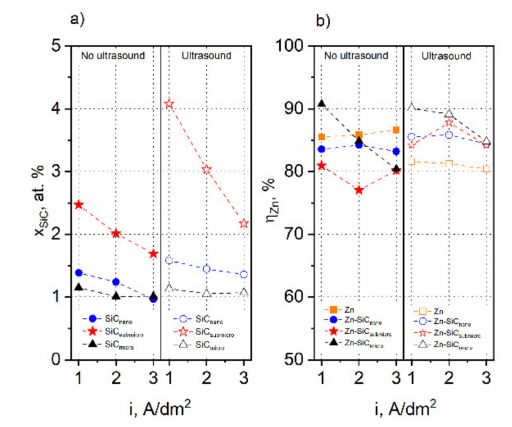
Figure 1. Parameters of coatings deposited at different current densities from an SiC free electrolyte and an electrolyte containing 5 g/L of SiC particles of different sizes. Coatings were deposited without and in presence of ultrasound. ( a ) SiC content in composite coatings, ( b ) cathodic current